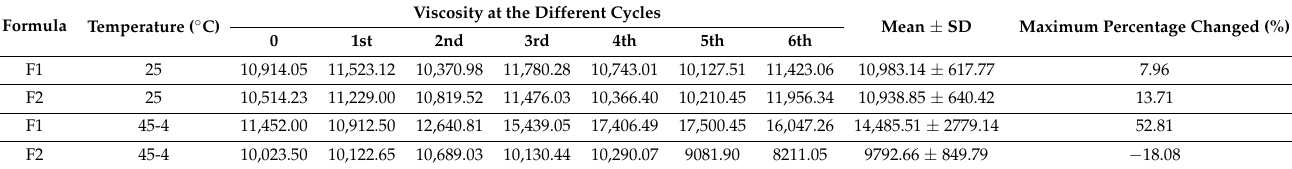
Table 3. Viscosity at the different cycles.